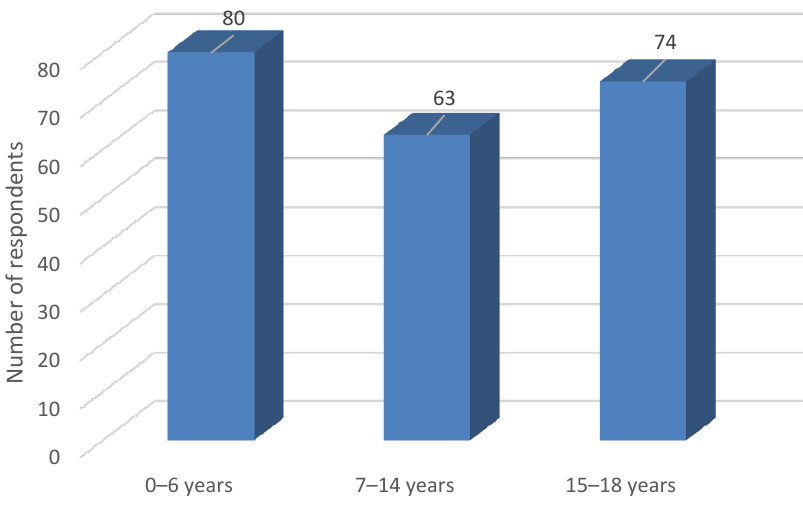
Figure 6. The number of individual age groups of children and adolescents in the respondents’ fam- ilies.